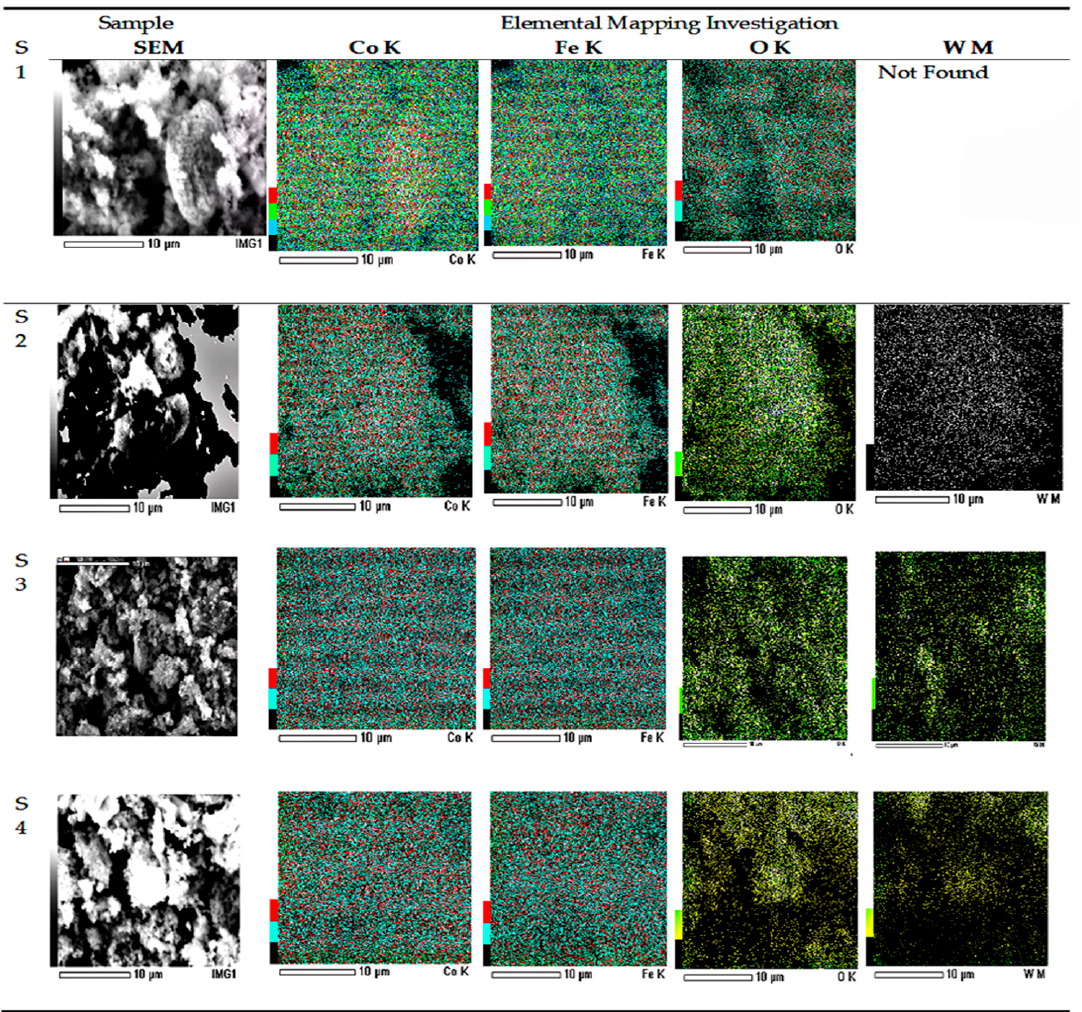
Figure 6. SEM and EDS Mapping of ( S1 ) CoFe 2 O 4 , ( S2 ) CoFe 2 O 4 (0.05% W-doping), ( S3 ) CoFe 2 O 4 (0.10% W-doping), and ( S4 ) CoFe 2 O 4 (0.15% W-doping).